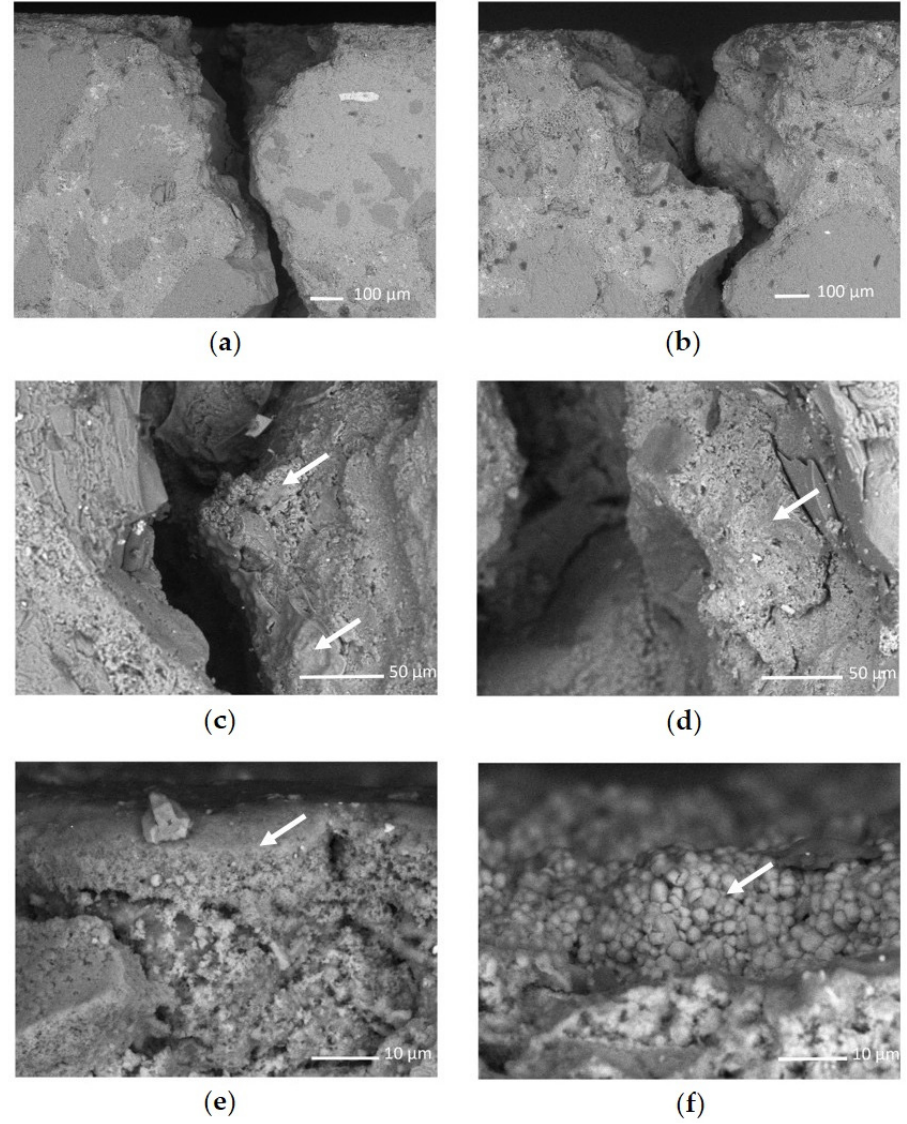
Figure 5. SEM images of samples treated with ( a , c , e ) ALK1 and ( b , d , f ) CFW, applied via absorption through capillarity (AP2), at different magnifications (( a , b ): 100 × ; ( c , d ): 500 × ; ( e , f ): 2000 × ). ( a , b ) At low magnification, it is evident that the crack was not filled with consolidants; ( c , d ) at higher magnifications, the consolidant material was deposited on the crack walls. At even higher magnifications, the morphology of different consolidants was clearly seen to be ( e ) needlelike and ( f ) spherical particle formation.